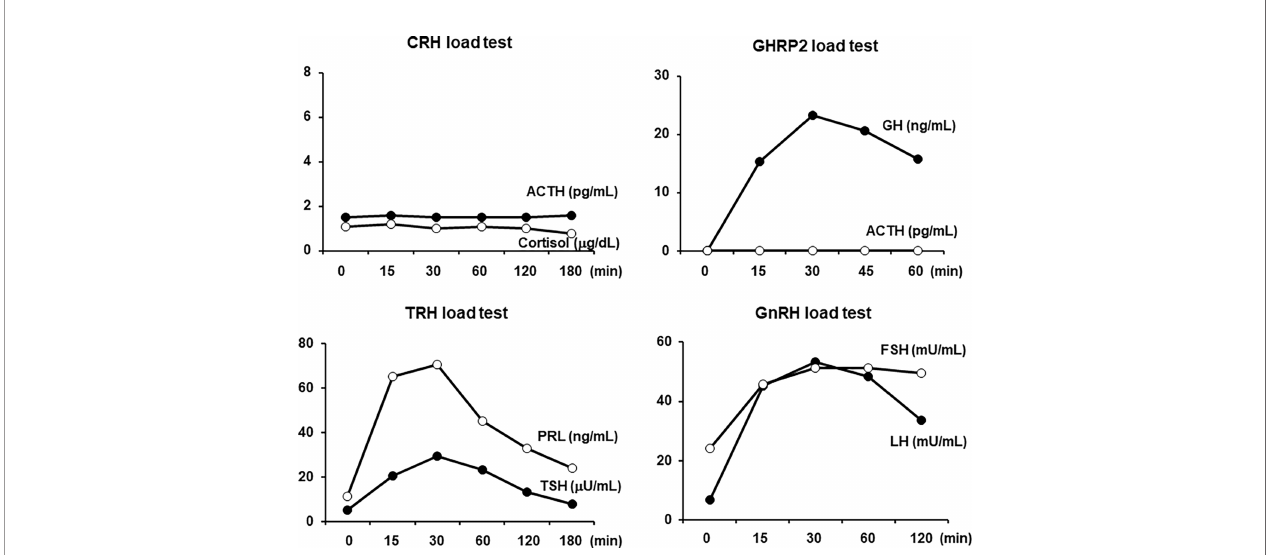
FIGURE 2 | In the corticotropin-releasing hormone (CRH) load test, both the adrenocorticotropic hormone (ACTH) and cortisol levels were not increased at all. In the growth hormone-releasing peptide 2 (GHRP2) load test, the GH level was normally increased, but the ACTH level was not increased at all. In the thyrotropin- releasing hormone (TRH) load test, both the thyroid-stimulating hormone (TSH) and prolactin levels were increased. In the gonadotropin-releasing hormone (GnRH) load test, both the luteinizing hormone (LH) and follicle-stimulating hormone (FSH) levels were normally increased. All load tests were performed in the morning in a fasting